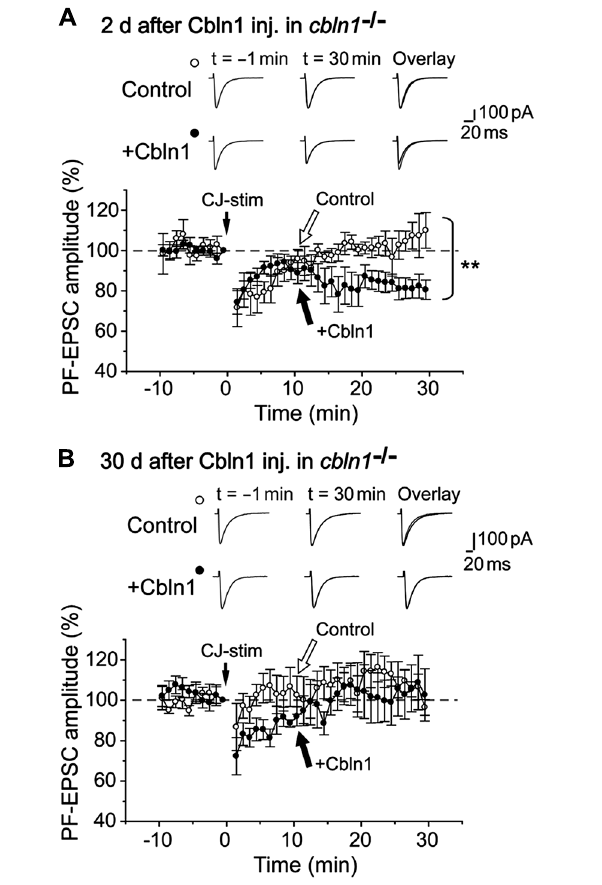
FIGURE 6 | Subarachnoidal Cbln1 injection transiently restores LTD at cbln1 − / − mouse PF–Purkinje cell synapses. A summary of LTD sessions in cerebellar slices prepared from cbln1 − / − mice at 2 days (A) and 30 days (B) after injection of Cbln1 ( + Cbln1), or control solution that did not contain Cbln1 (Control). The averaged amplitudes of the PF–EPSC over 1 min were normalized to the baseline value, which was the average of the 1 min responses (six traces) that occurred just before a conjunctive stimulation (CJ-stim) composed of 30 single PF stimuli together with 200-ms depolarizing pulses from a holding potential of –60 to + 20 mV. Inset traces show the PF–EPSCs just before ( t = –1 min) or 30 min ( t = 30 min) after the CJ-stim, and their superimposition (overlay). Note that LTD was significantly restored in cbln1 − / − mice at 2 days after Cbln1 injection (** p < 0.05, control vs. Cbln1, Mann − Whitney’s U test, n = 5 for control, n = 6 for Cbln1), but not at 30 d after injection ( p > 0.5, control vs. Cbln1, Mann − Whitney’s U test, n = 5 for control, n = 6 for